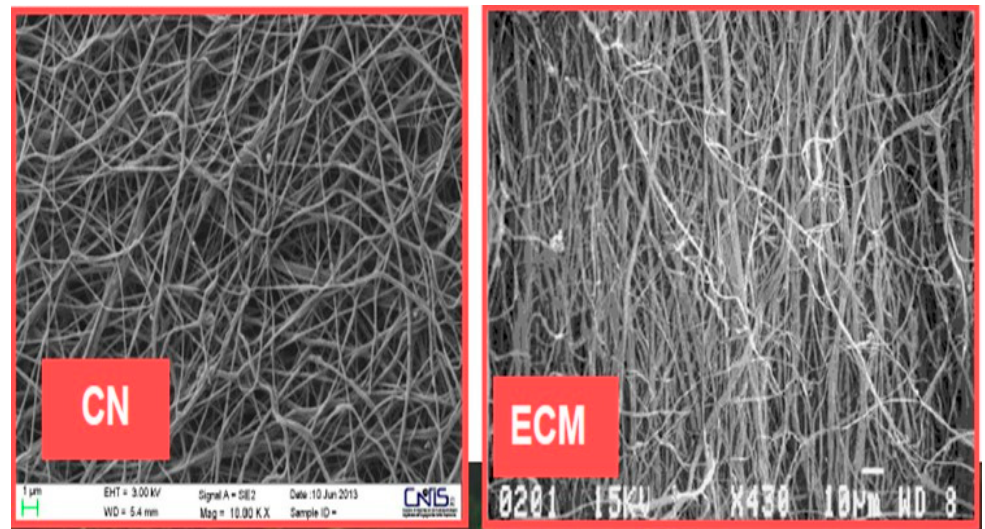
Figure 7. The CN-tissue structure at SEM (left) compared to natural ECM (right).